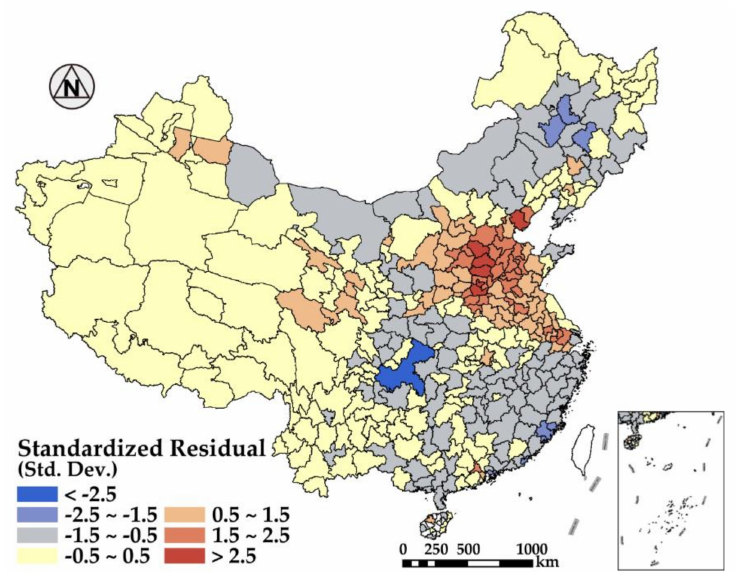
Figure 11. The standardized residual of GWR at prefectural